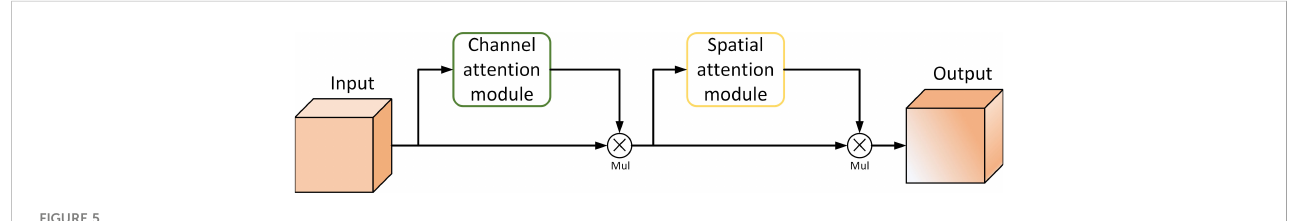
FIGURE 5 The structure of the CBAM module.